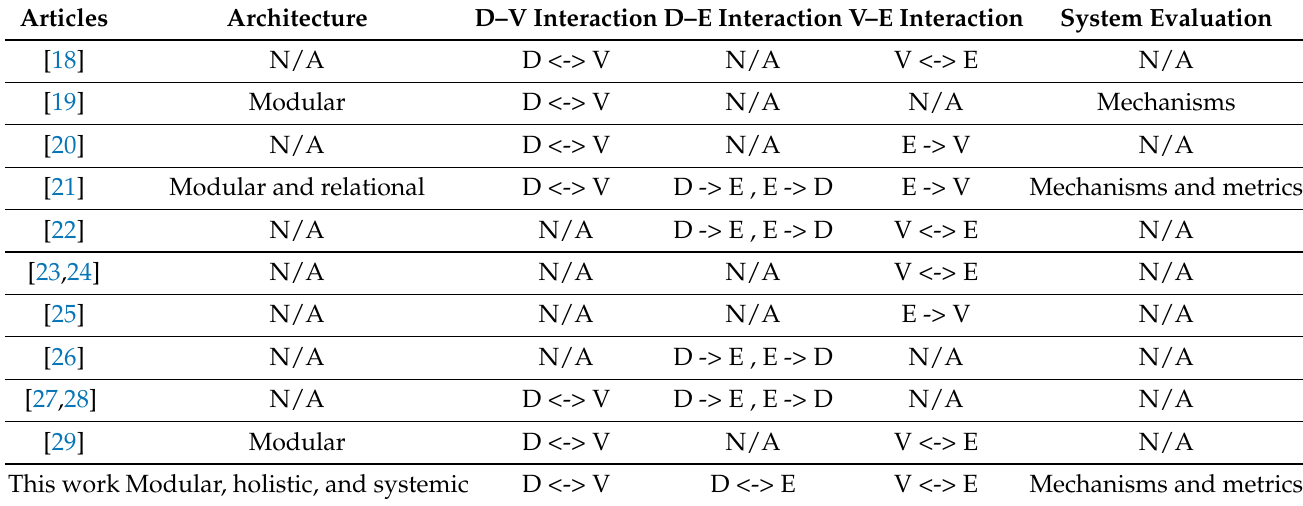
Table 1. Analysis of the main characteristics and limitations of other published surveys and this work in terms of architecture, system evaluation, and interactions between elements, considering D–V interaction, D–E interaction, and V–E interaction; specifying whether this relationship is bidirectional (<->) or unidirectional (->). Cases where these topics are not addressed (N/A) are also